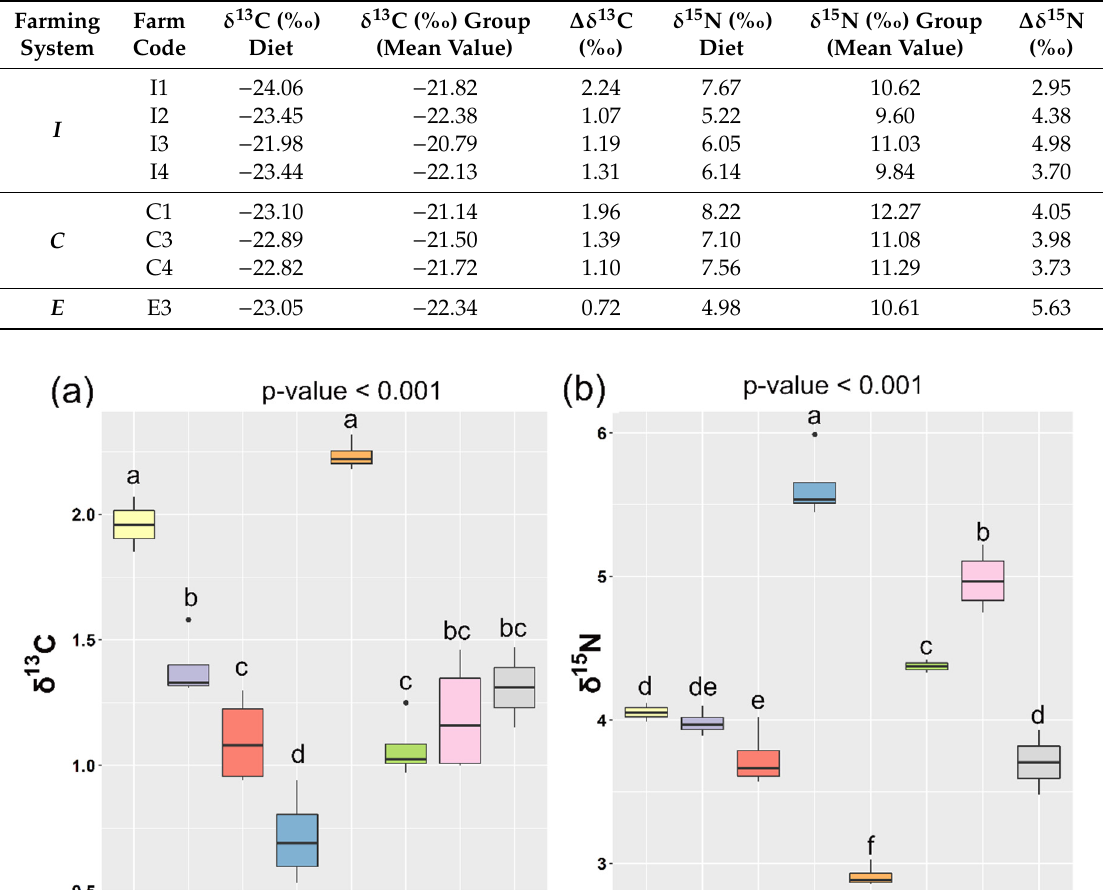
Table 4. δ 13 C and δ 15 N trophic shifts for intensive (inland and sea cages) or semi-intensive (E3) reared sea bass.